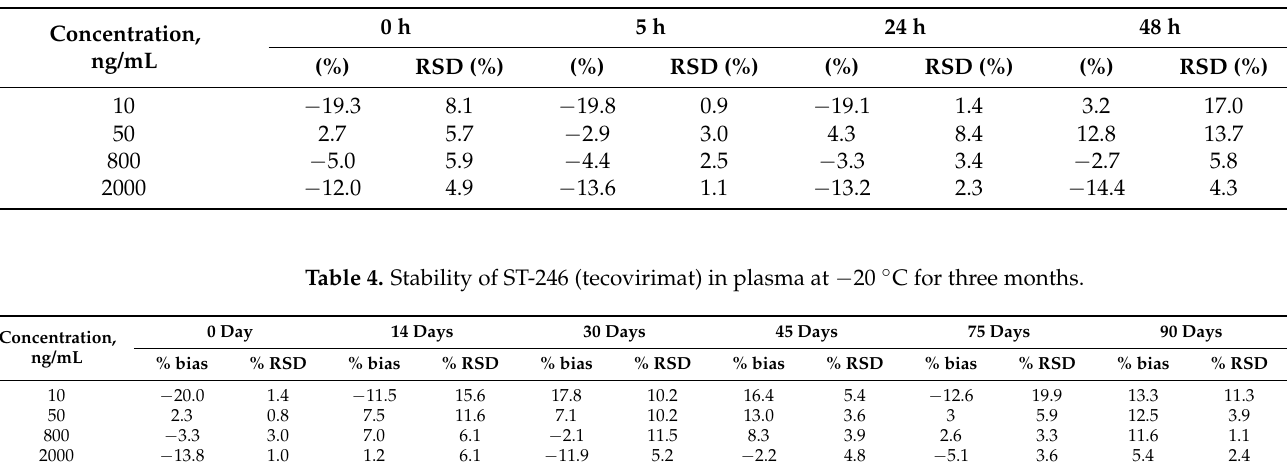
Table 3. Stability of ST-246 (tecovirimat) in plasma at 4 ◦ C for 48 h.